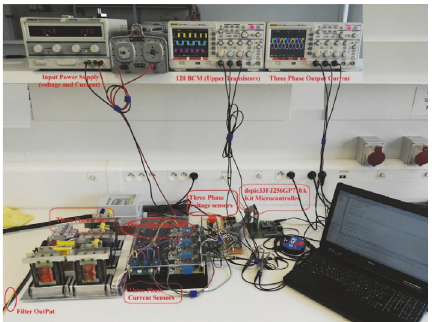
Figure 9: Full system designed setup of three-phase inverter under (120BCM).